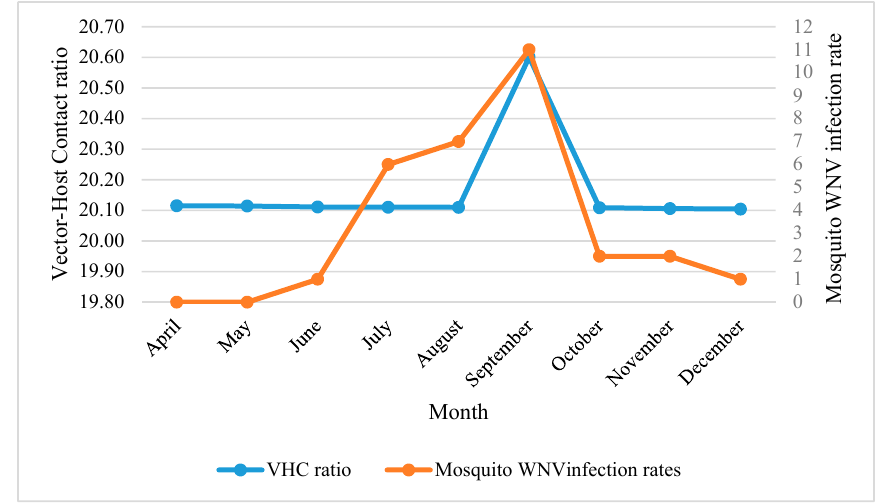
Figure 3. Monthly mosquito WNV infection rate in correlation with vector-host contact ratios in NOLA.